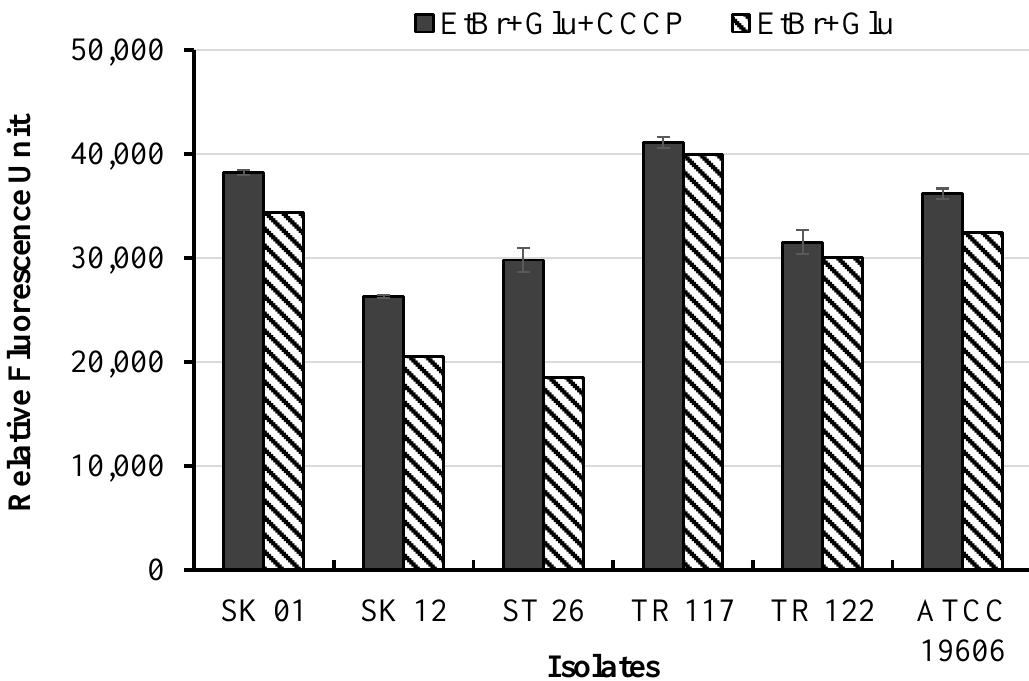
Figure 3. Fluorescence intensity of cells exposed to ethidium bromide in the presence and absence of carbonyl cyanide 3-chlorophenyl hydrazone.